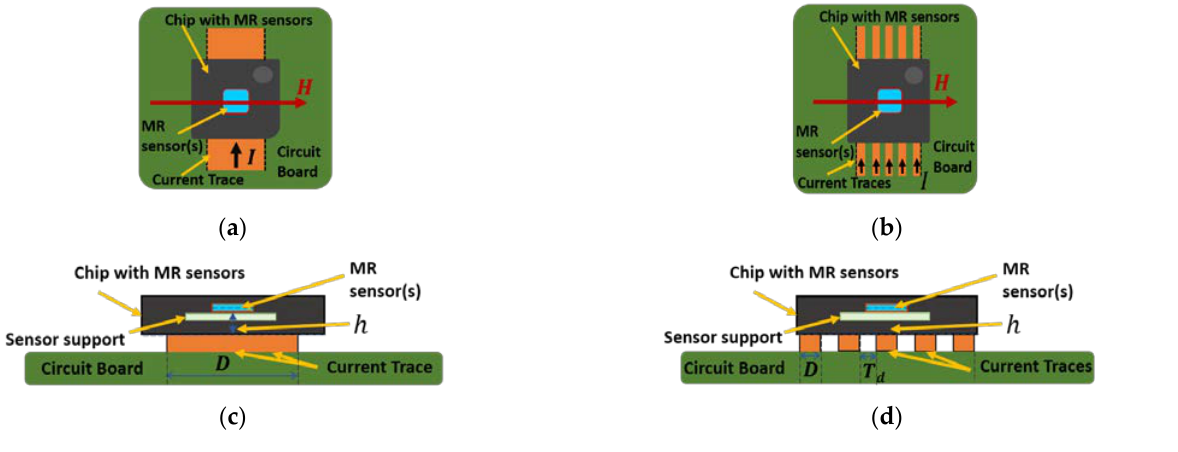
Figure 2. Working principle of the non-contacting current measurement setup utilizing current traces and a MR-based chip: ( a ) Single trace plane section; ( b ) Multi-trace plane section; ( c ) Single trace cross section; ( d ) Multi-trace cross section (adapted from [15]).